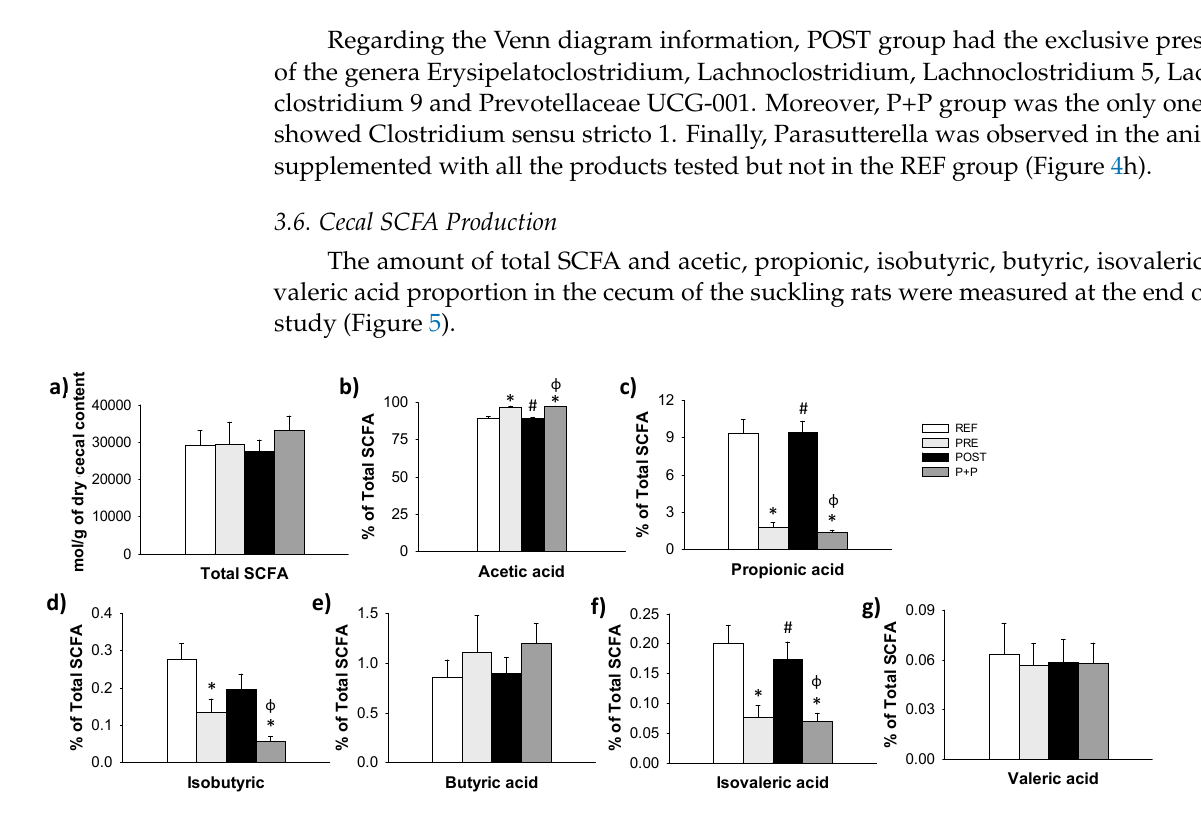
Figure 5. SCFA production in cecal samples of 16-day-old suckling rats. Total SCFA ( a ), acetic ( b ), propionic ( c ), butyric ( d ), isobutyric ( e ), isovaleric ( f ) and valeric ( g ) acid proportion (µmol/g of cecal content). Results are represented as mean ± SEM (n = 8–12 samples/group). Statistical significance: * p < 0.05 vs. REF, # vs. PRE and ϕ vs. POST. REF: reference group; PRE: group supplemented with a mixture of scGOS and lcFOS; POST: group supplemented with Lactofidus TM ; P+P: group supplemented with the combination of both.